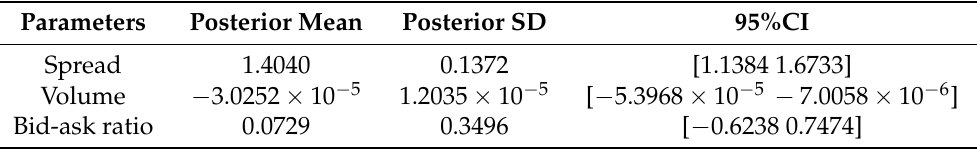
Table 27. Estimated parameters about limit order book (23 June 2016, JAL, Tokyo, Japan).